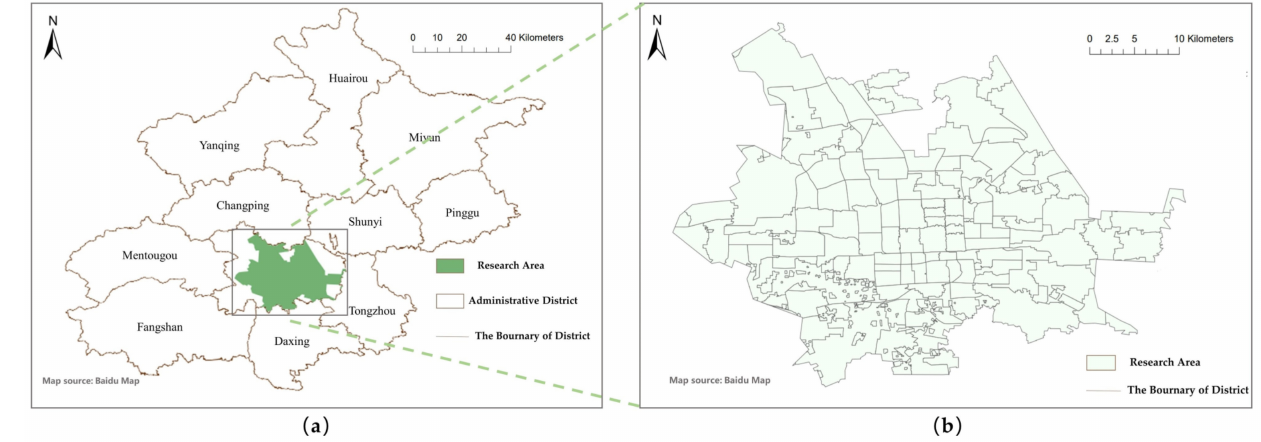
Figure 1. ( a ) Research area in Beijing; ( b ) Research Area of the darkened place in ( a ).